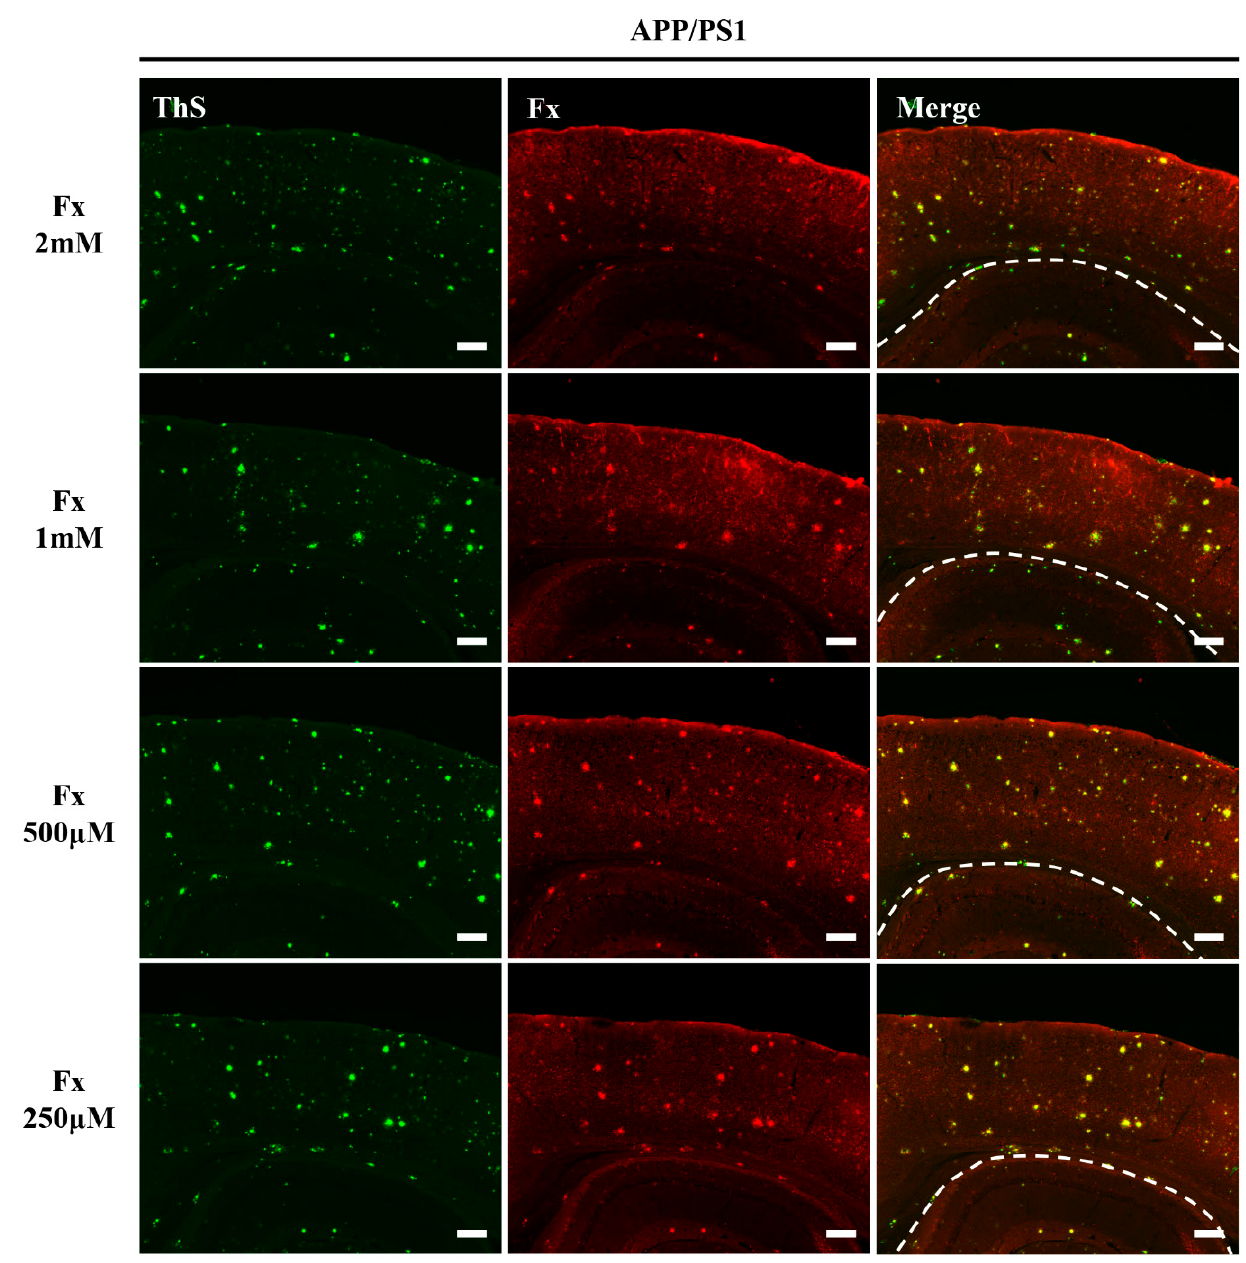
Figure 5. Fucoxanthin staining using organic solvent-based washing method detected ThS-positive A β plaques in APP/PS1 brain tissue. The brains of 10–15-month-old APP/PS1 mice ( n = 4) were visualized for A β plaques with fucoxanthin (Fx) and ThS. The images of ThS and Fx are merged to confirm that they are colocalized. Scale bars = 200 μ m. The region of brain was separated with the white dash line on the images; upper region of dash line, cortex; under region of dash line, hippocampus.